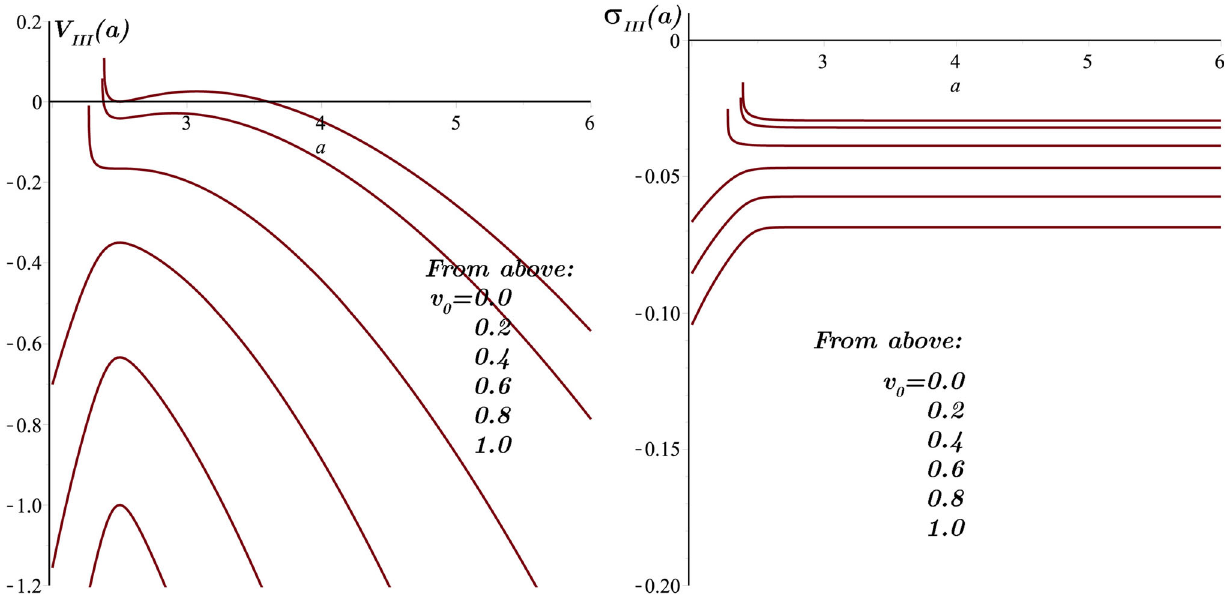
= 16, M = 1 and from above v 0